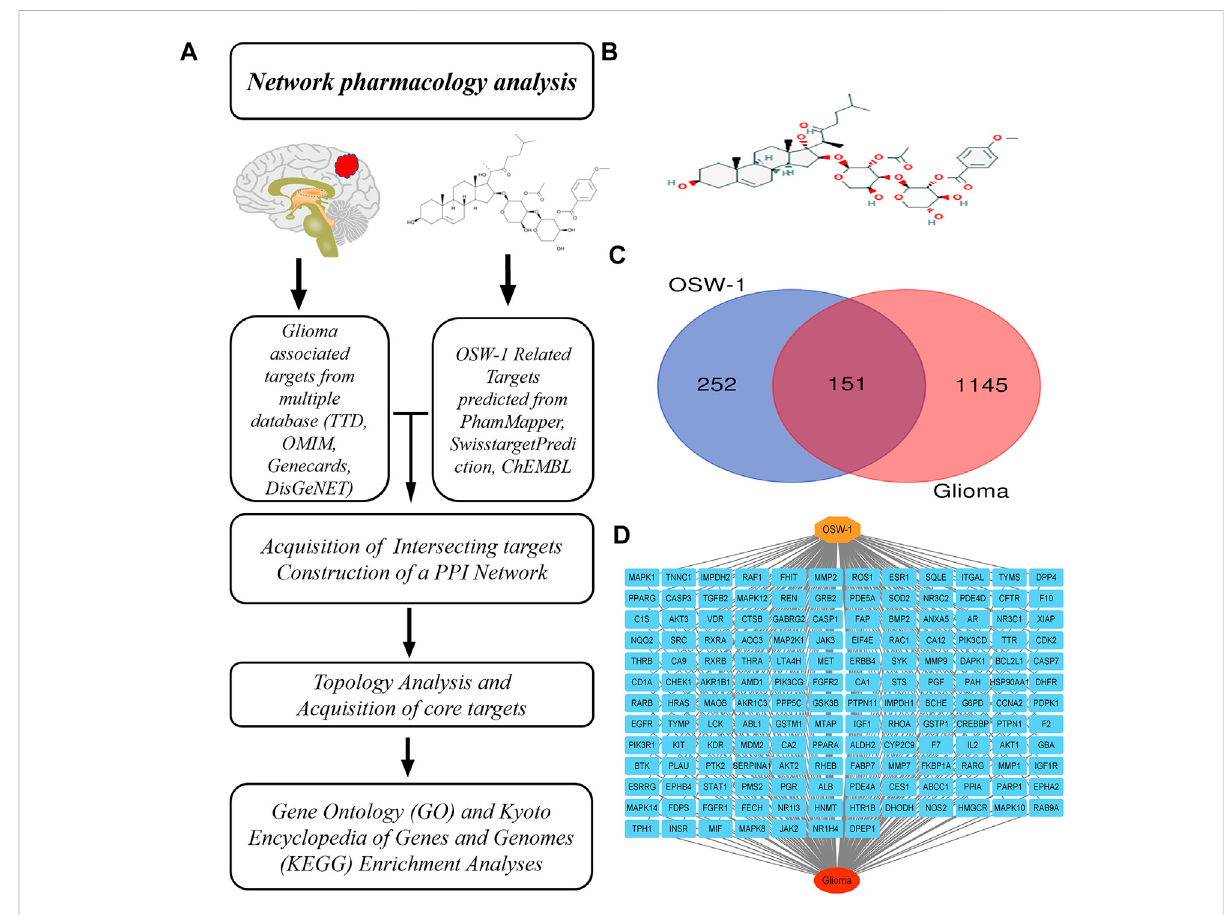
FIGURE 1 Network pharmacology of OSW-1 on glioma (A) The schematic fl owchart of the present network pharmacology analysis (B) The 2D chemical structure of OSW-1 (C) The Venn map of OSW-1-targets and Glioma-related genes (D) The “ OSW-1-Targets-Glioma ” intersection